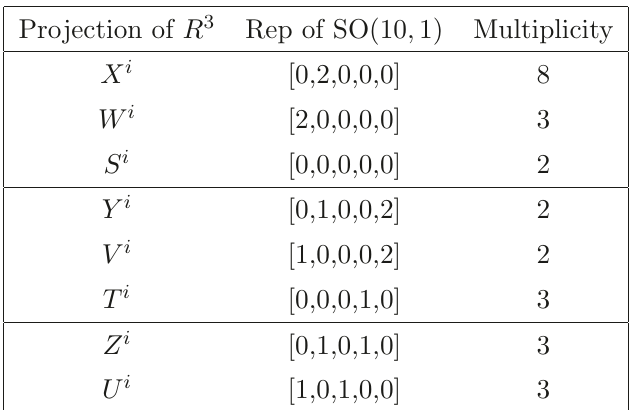
Table 5 . Relevant projections of corresponding